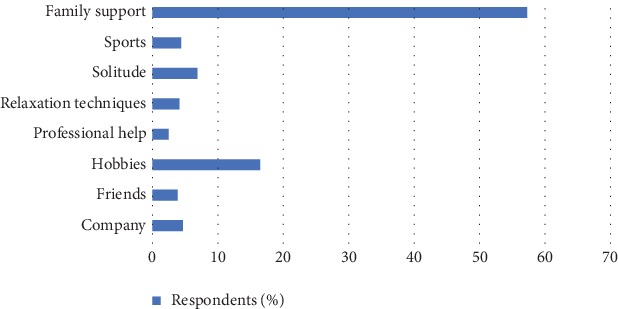
Most common defense against burnout.